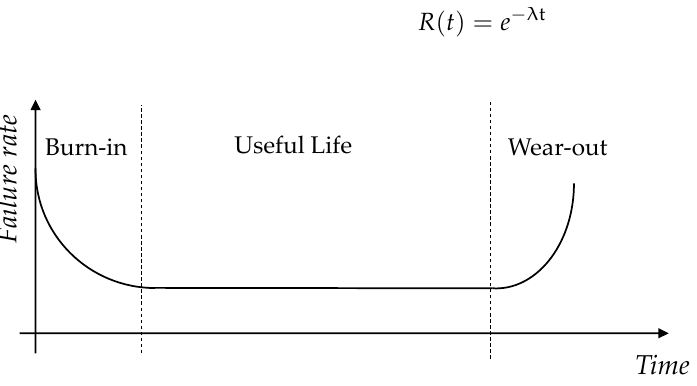
Figure 1. Bathtub curve of a generic component during time.